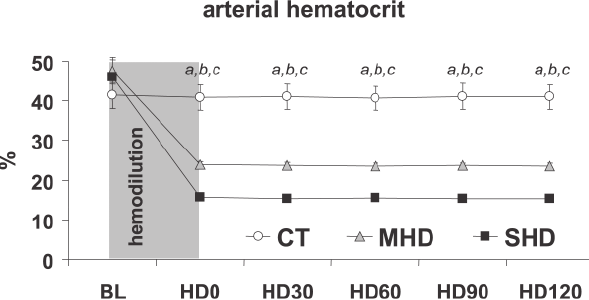
Figure 1 - Arterial hematocrit during the experiment in the control (CT), moderate hemodilution (MHD), and severe hemodilution (SHD) groups. (a) MHD vs CT, P < 0.05; (b) SHD vs CT, P < 0.05; (c) MHD vs SHD, P <